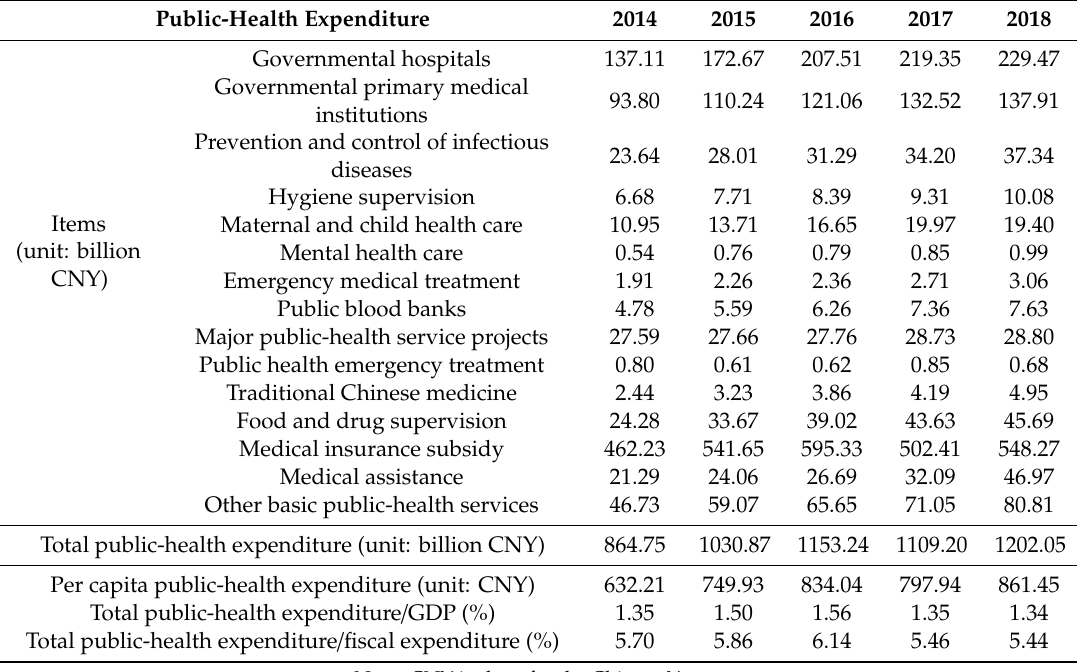
Table 1. Chinese public-health expenditure at national level from 2014–2018.